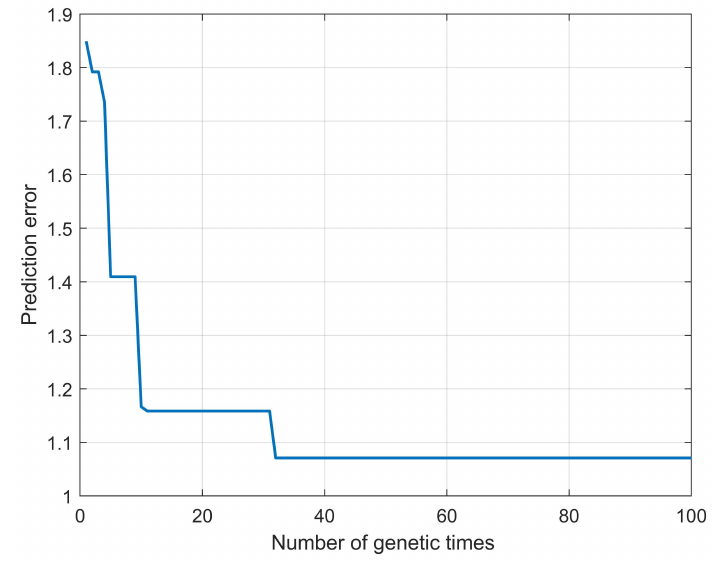
Figure 9. The change process of prediction errors of